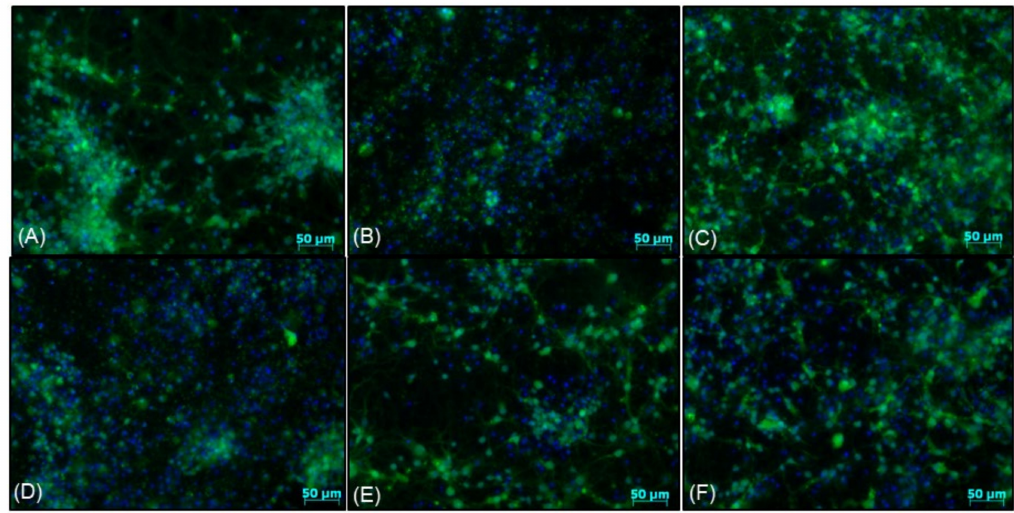
Figure 10. Representative microphotographs of primary neurons pre-treated for 30 min. with MC (1–50 µ M) or co-treated with N-acetylcysteine (NAC, 1 mM) followed by 24 h of exposure to H 2 O 2 (0.2mM).Afterthetreatmentthecellsweredouble-stainedwithCalceinAM(green) / Hoechst33,342(blue) dyes and live imaged with fluorescence microscopy. ( A )—control; ( B )—H 2 O 2 ; ( C )—H 2 O 2 + NAC; ( D )—H 2 O 2 + MC 1; ( E )—H 2 O 2 + MC 10; ( F )—H 2 O 2 + MC